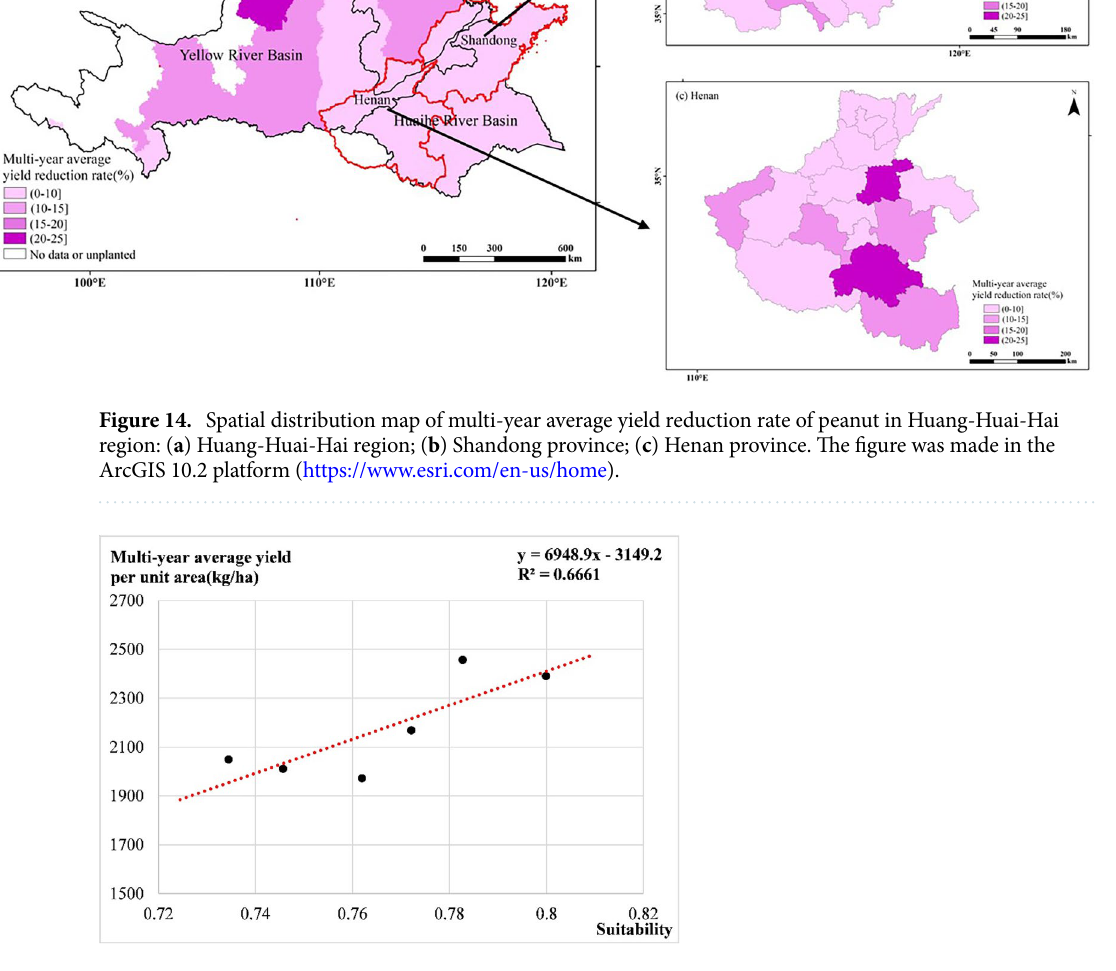
Figure 15. Correlation of multi-year average yield per unit area and comprehensive suitability of peanut in Huang-Huai-Hai